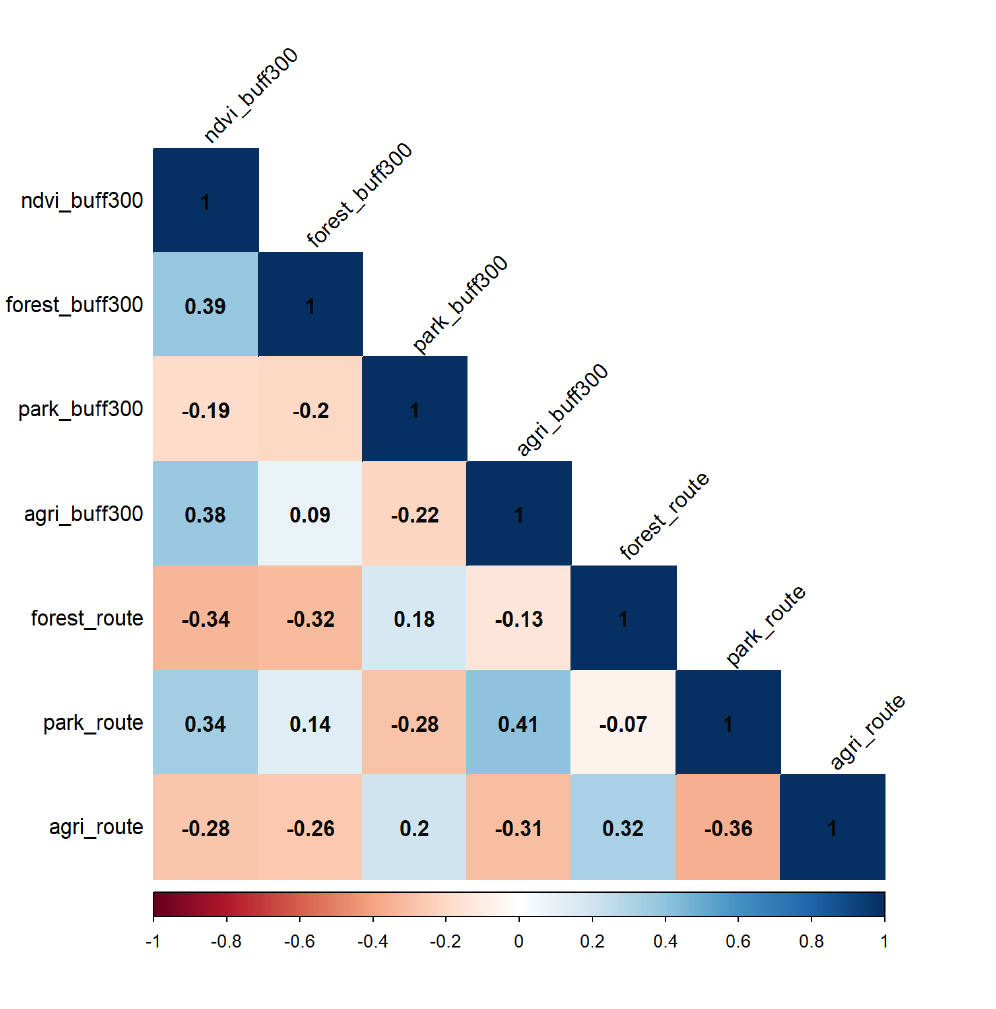
Figure S2 . Pairwise correlation between greenspace